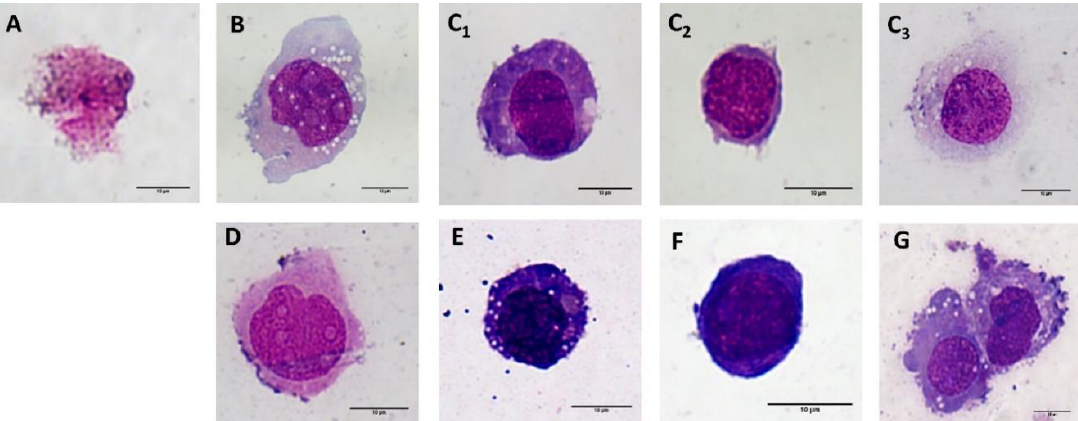
Figure 6. Microscopic analysis of the morphological changes on the THP-1. Representative images of the monocytic THP- 1 cells after 7 days of incubation with 100 μg/ml SiC– x NPs ( A ), SiC – NH 2 ( B ) and SiC – OH ( C 1 — dendritic cell-like; C 2 — monocytic; and C 3 — macrophage-like). Control cells (monocytes, incubated in the same manner as the NP-treated cells (10,000 cells/cm 2 ) ( D ), chemically- differentiated monocytes to dendritic-like cell morphology ( E ), monocytes (kept in the culture – 133 000 cells/cm 2 ) ( F ), and chemically-differentiated macrophage-like cells (PMA treatment) ( G ). All the images were captured at 100× magnification; the scale bar represents 10 µm.